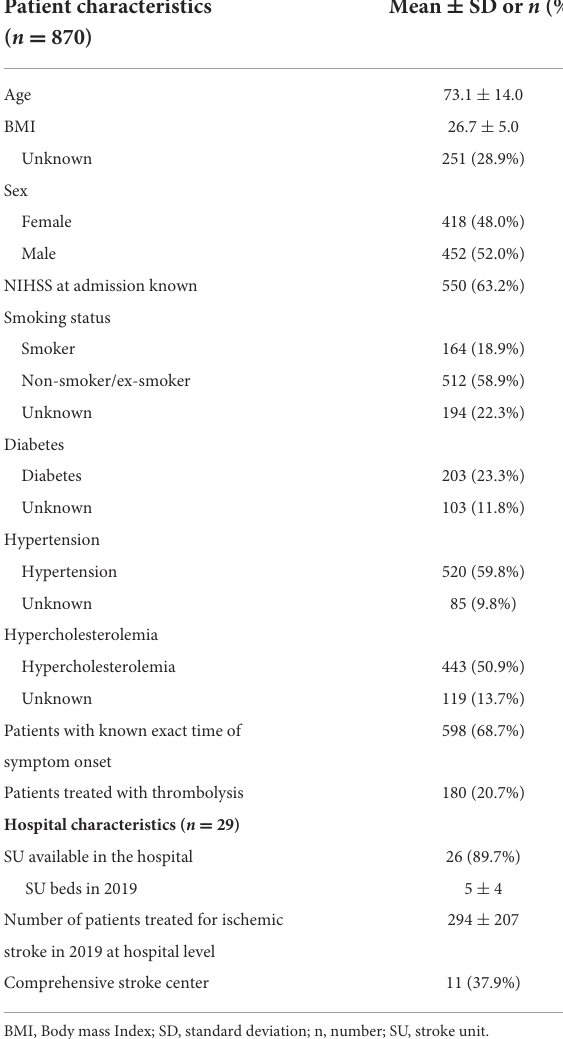
TABLE 2 Patient and hospital